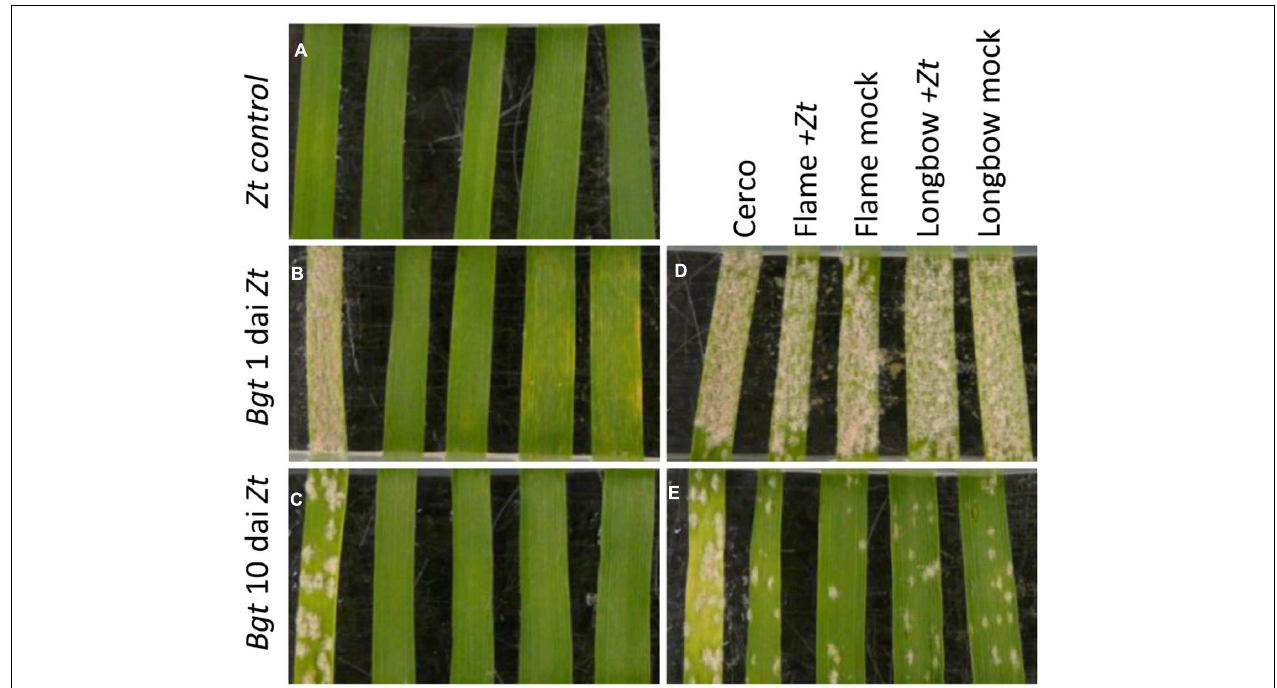
FIGURE 4 | The effect of non-viable Z. tritici spores on mildew colony development. Order of leaves in each photograph, from left: Cerco, Flame IPO323, Flame mock, Longbow IPO323, Longbow mock. (A) Inoculated only with non-viable Z. tritici spores. (B) and (C) Inoculated with non-viable Z. tritici then with avirulent B. graminis f.sp. tritici ( Bgt ) isolate JIW11. (D) and (E) Inoculated with non-viable Z. tritici virulent Bgt isolate JIW48. (B) and (D) Inoculated with Bgt 1 day after Z. tritici inoculation. (C) and (E) inoculated with Bgt 10 days after Z. tritici inoculation. Photographed 21 days after inoculation with Z. tritici.